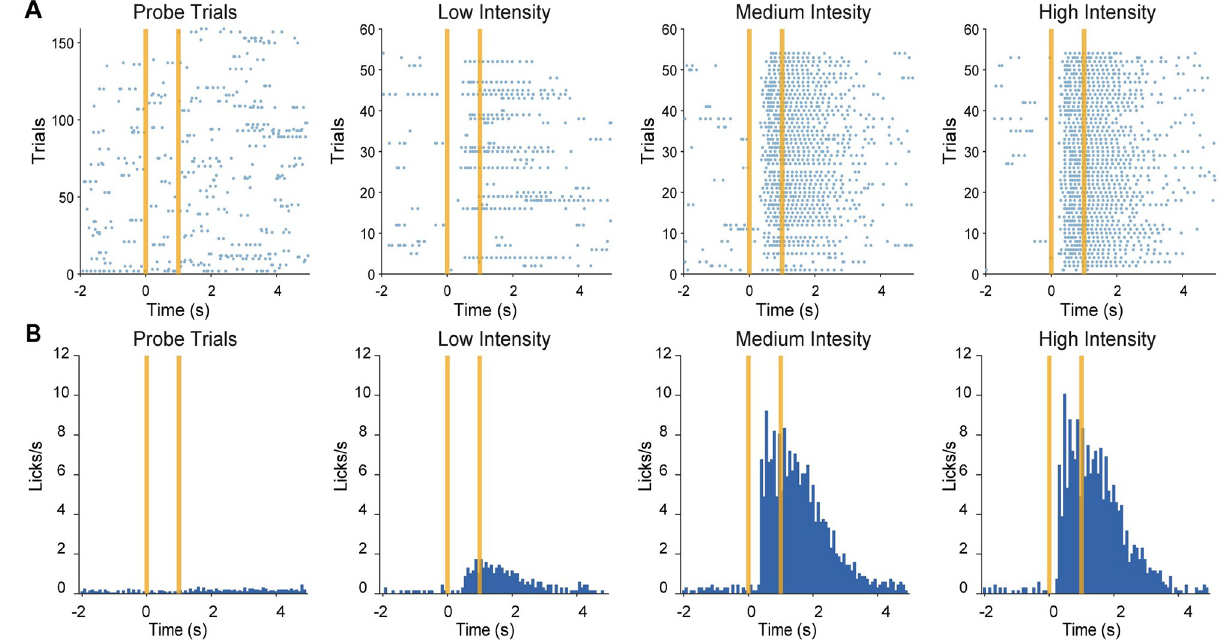
Fig 3. Licking behaviour. (A) Licking activity during one example session from M3 in the Final Stage (blue dot: individual lick). From left to right, each lick raster plot corresponds to increasing tactile intensities from probe trials to low, medium, and high intensity tactile trials. The vertical lines indicate the start and end of sensory stimuli. (B) Same as panel A , but for lick peristimulus time histograms (time bin: 80 ms).